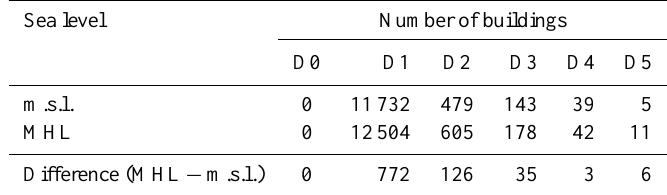
Table A3. Number of buildings per level of damage in case of mean sea level (m.s.l.) and of maximum high-tide level